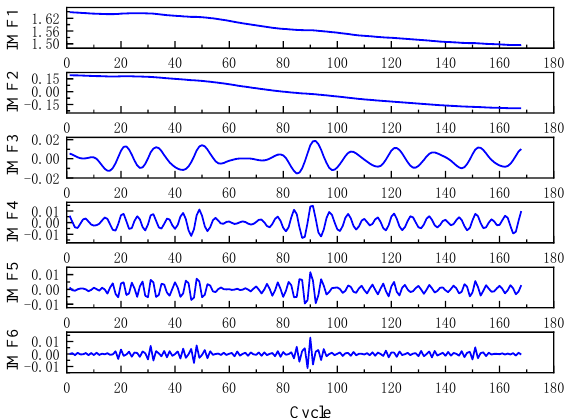
Figure 6. Modal components of WOA-VMD decomposition.